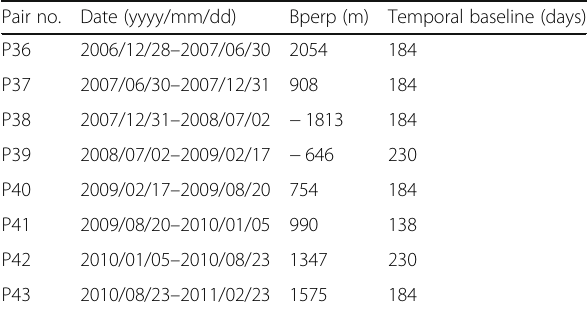
Table 3 ALOS/PALSAR datasets for MAI images in Fig. 6. Details of the orbit, incidence, and heading angle are the same as in Table 1 Pair no. Date (yyyy/mm/dd)